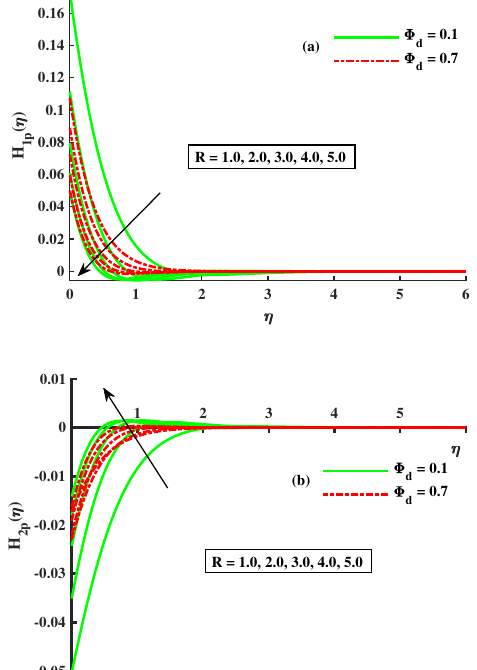
Figure 5. Influence of φ d & R on ( a ) H 1 p ( η ) & ( b ) H 2 p ( η )